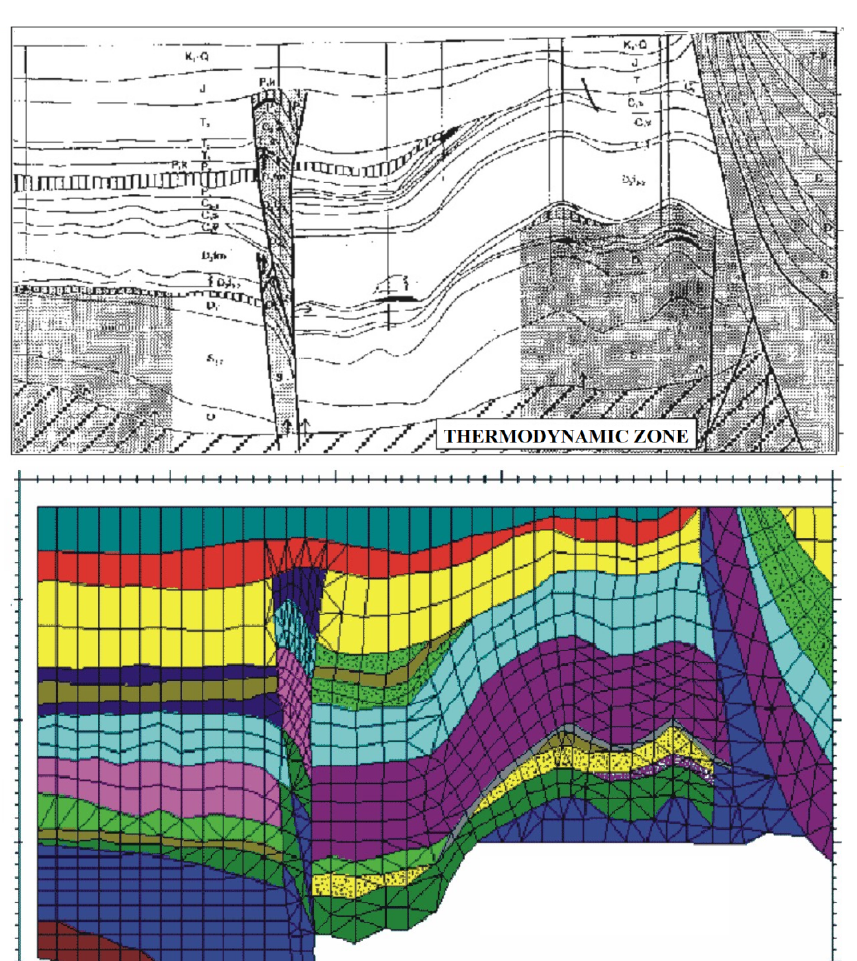
Figure 2. Geological profile of the Varandey–Adzvinskaya structure zone (above): K1–Q—Lower Cretaceous–Quaternary, J—Jurassic, T3—Upper Triassic, P2—Upper Permian, P1—Lower Permian, C1–P1—Lower Carboniferous–Lower Permian, D3—Upper Devonian, D2—Mid Devonian, S1— Lower Devonian Ordovician, D—Devonian, S—Silurian, T–P—Triassic–Permian; grid approximation of the upper profile